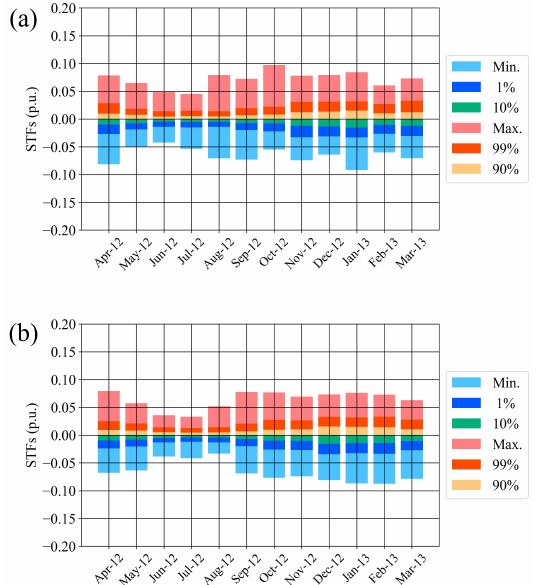
Figure 11. The maximum, minimum, and percentiles of short-term fluctuations (STFs) in each month in the Tohoku area for the fiscal years of ( a ) 2010 and ( b ) 2011.